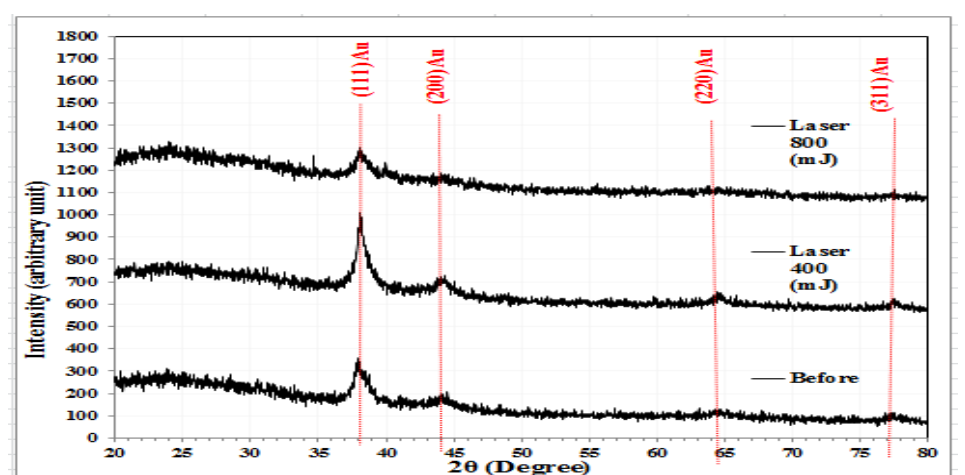
Fig. 9: X-ray diffraction pattern of B-alloy colloid NPs for exploding currents 100A and synthesized by (400 m J, 800 m J) laser energies Irradiation.